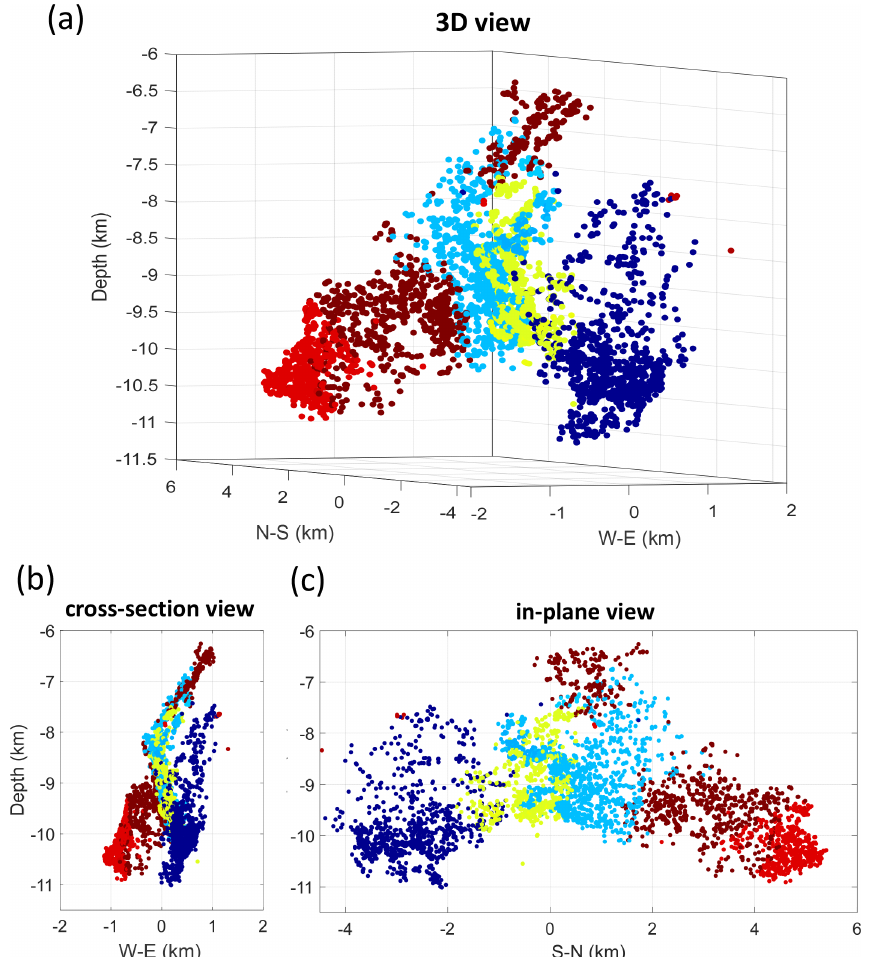
Figure 3. The earthquakes foci with local magnitude M L ≥ 0 . 5 in (a) 3D view, (b) cross-section vertical view, and (c) in-plane vertical view. The foci are colour-coded according to time: dark blue – 2008, light blue – 2011, yellow – 2014, red – 2017, and brown – 2008.